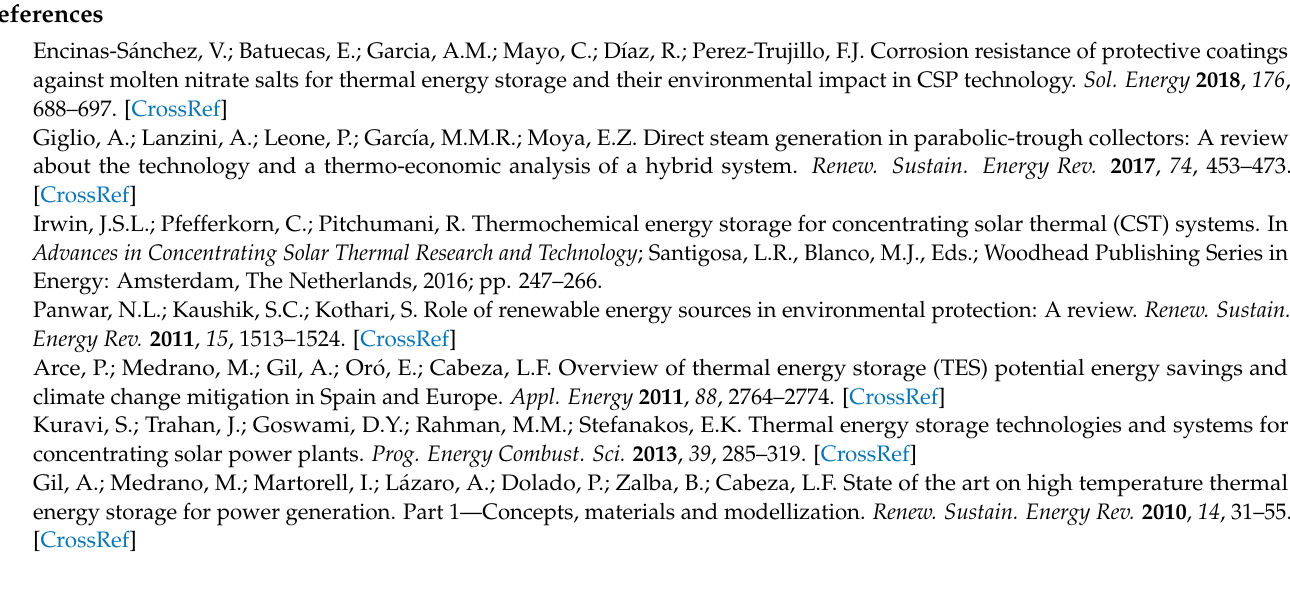
mode. Table S2. Various theoretical reaction models for kinetic analysis of solid-state reactions. Table S3. Chemical composition of test material, test atmosphere, and kinetic data of HC mode for the present and previous studies using Fe-substituted Mn 2 O 3 . The kinetic data for non-substituted Mn 2 O 3 samples are listed as a comparison. Figure S1. The RSS values of estimated (a) A2 and (b) R2 reaction models against variations in fractional conversion during the HC mode at all heating rates. The experimental kinetic data of the long-term cycled sample are fitted to the estimated A2 and R2 reaction models. The RSS values are calculated. Figure S2. Relationship between pre-exponential factor, A , of (a) A2 model and (b) R2 model and heating rate, β , for the long-term cycled sample. Error bar of all plots is standard deviations in all fractional conversion ranges of α = 0–1.0. Figure S3. Relationship between pre-exponential factor, A , of (a) R3 model and (b) F1 model and heating rate, β , for the as-prepared sample. Error bar of all plots is standard deviations in all fractional conversion ranges of α =